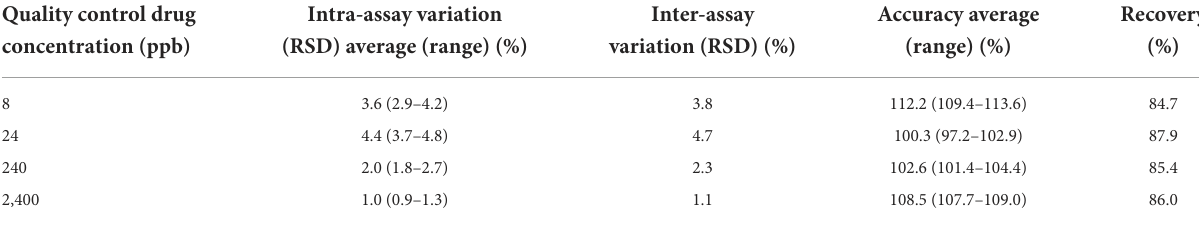
TABLE 1 Sensitivity, precision and accuracy parameters for the ultra-performance liquid chromatography with tandem mass spectrometry analytical method used to measure florfenicol concentrations in goat milk following florfenicol administration to lactating does. Quality control drug